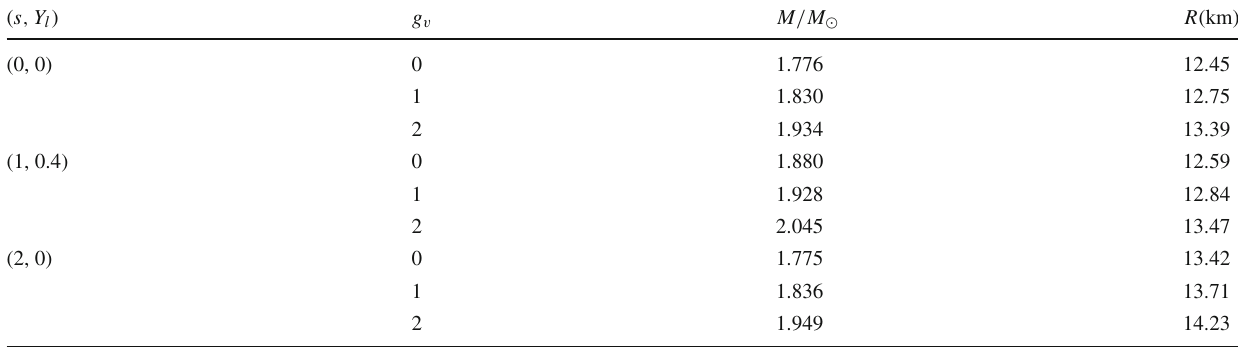
Fig. 8 Mass-radius relation of SQSs for various vector interactions/moments of the star evolution defined by entropy and lepton fraction with the M (cid:2) ) and PSR J0348+0432 (2 . 01 ± 0 . 04 M (cid:2) ) [20] observational constraints for maximum mass required by PSR J0740-6620(2.14 + 0 . 10 − 0 . 09 Table 4 The values of maximum gravitational mass, M / M (cid:2) and corresponding radius, R , for strange quark stars are